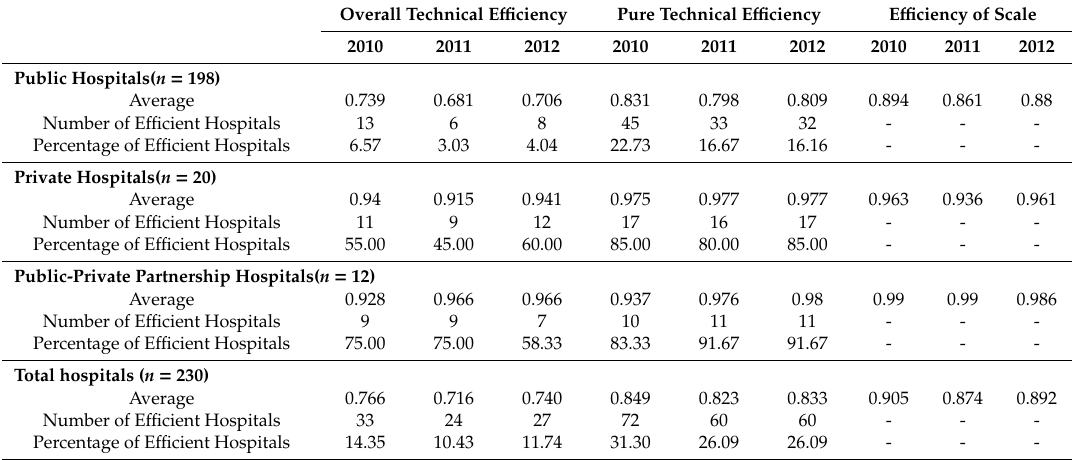
Table 4. Technical e ffi ciency of the Spanish National Health System general hospitals, according to ownership. 2010–2012.